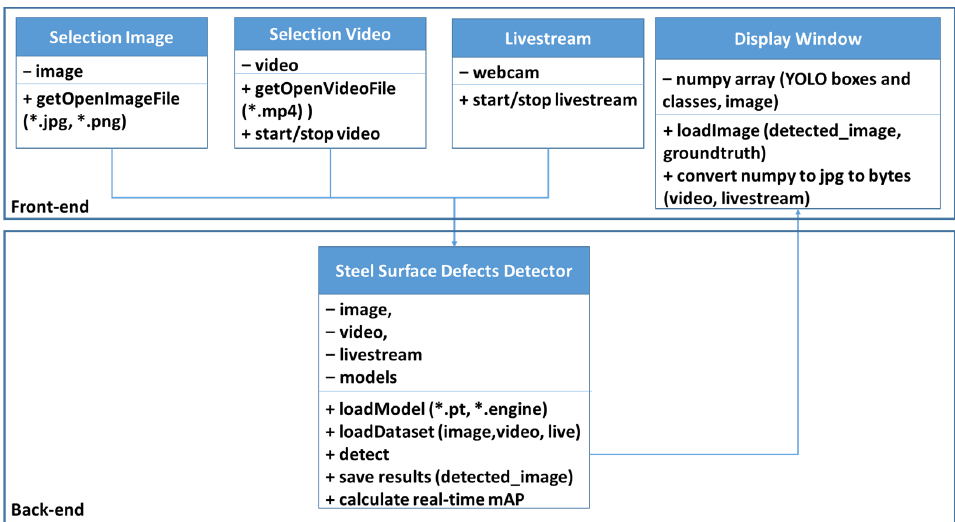
Figure 3. UML of our demo